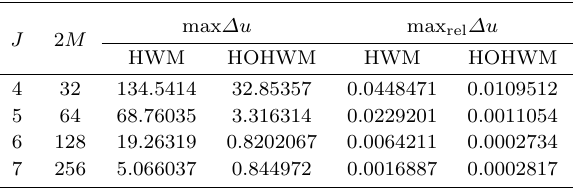
Table 3. Results for the KdV equation: maximal deviation of the numerical solution from the exact solution max ∆u and maximal relative deviation max rel ∆u against the resolution parameter J with initial conditions (5.3) and boundary conditions (4.11) ( α = 1, c = 1000, x